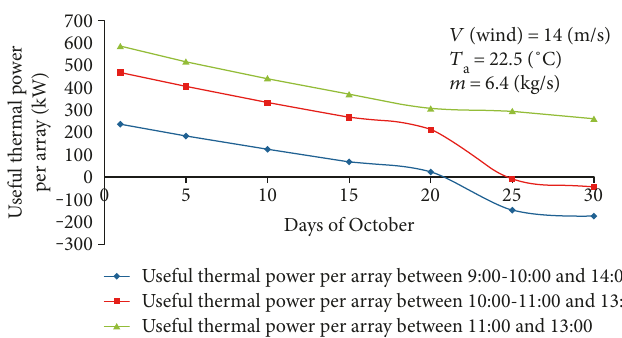
Figure 11: Useful thermal power per array for October.